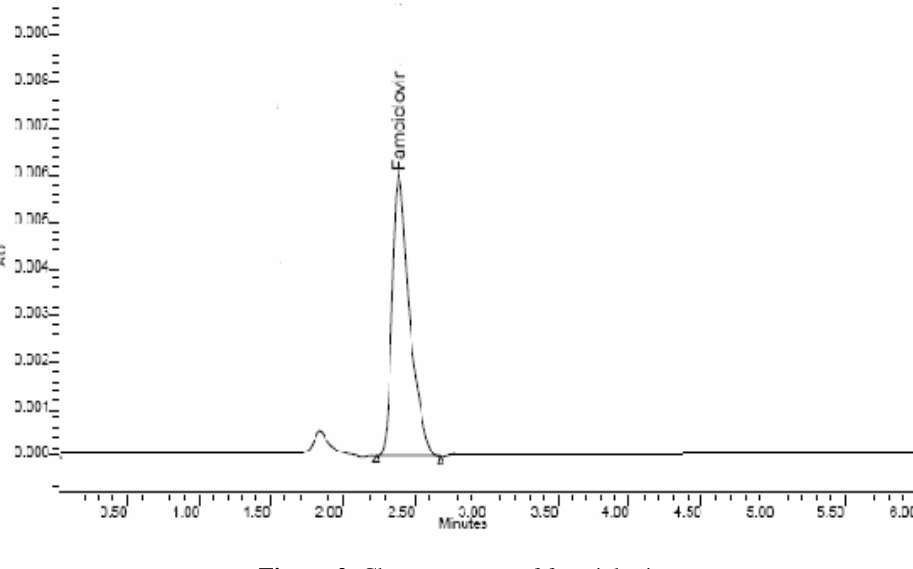
Figure 2. Chromatogram of famciclovir.